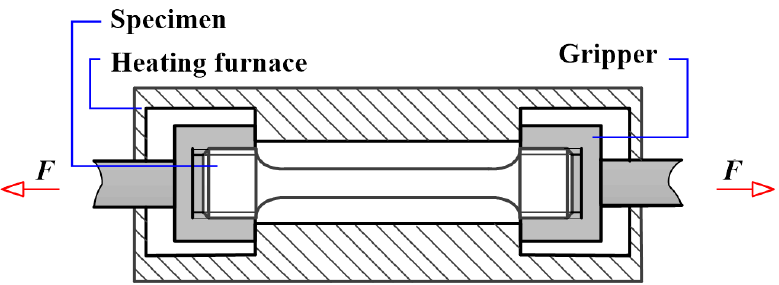
Figure 1. Schematic diagram of the isothermal uniaxial tensile experiment.